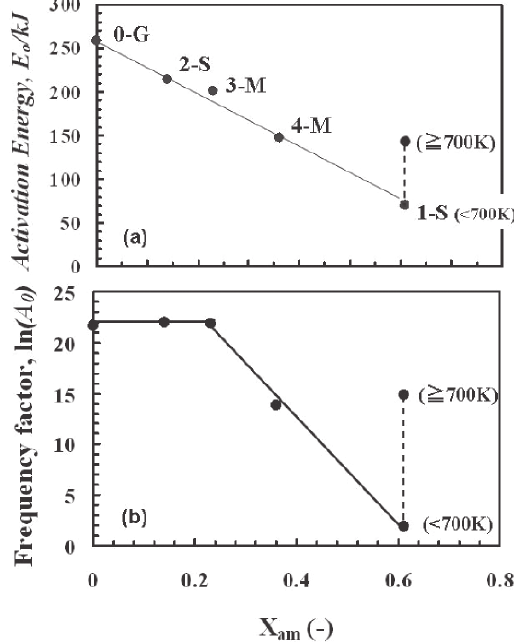
Fig. 7: Activation energies and frequency factors in terms of amorphous carbon, X am